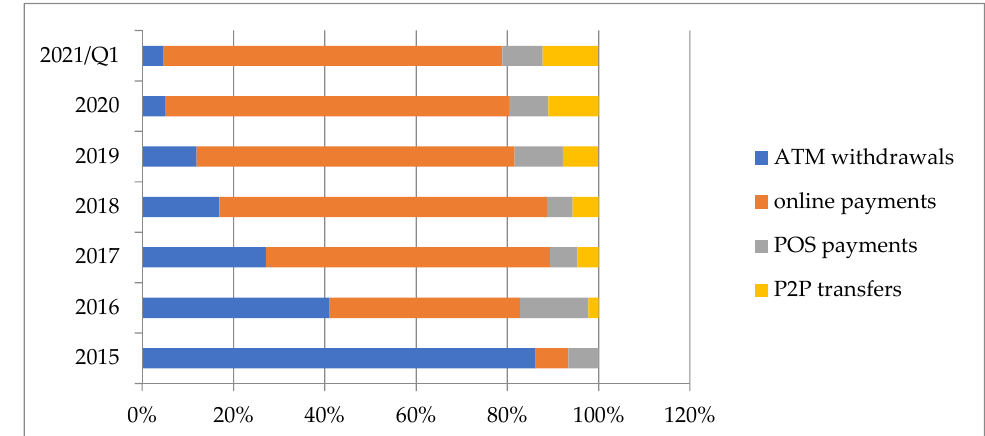
Figure 4. The structure of transaction in BLIK. Source: own elaboration based on NBP Reports (2015–2021): Informacja o rozliczeniach pieniężnych i rozrachunkach międzybankowych w latach 2015